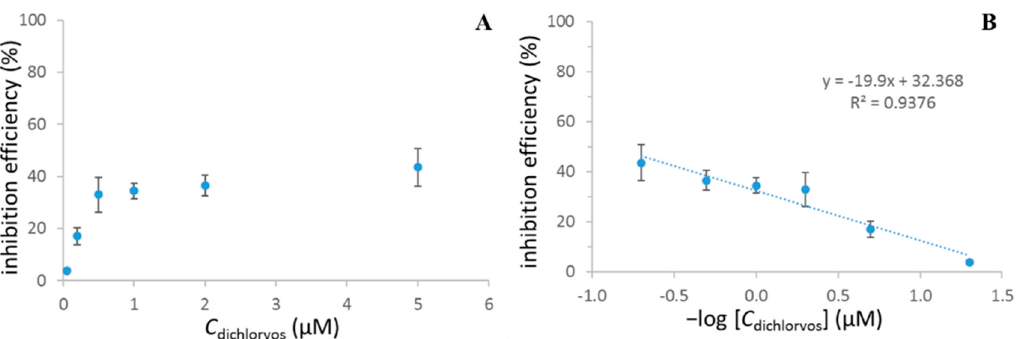
Figure 2. The plots of inhibition efficiency vs. dichlorvos concentration ( A ) and inhibition efficiency vs. the logarithm of dichlorvos concentration ( B ). The concentrations of QDs, acetylcholinesterase (AChE) and choline oxidase (ChOx) in all experiments were 2.5 nM, 40.8 U/mL and 637.5 U/mL, respectively.